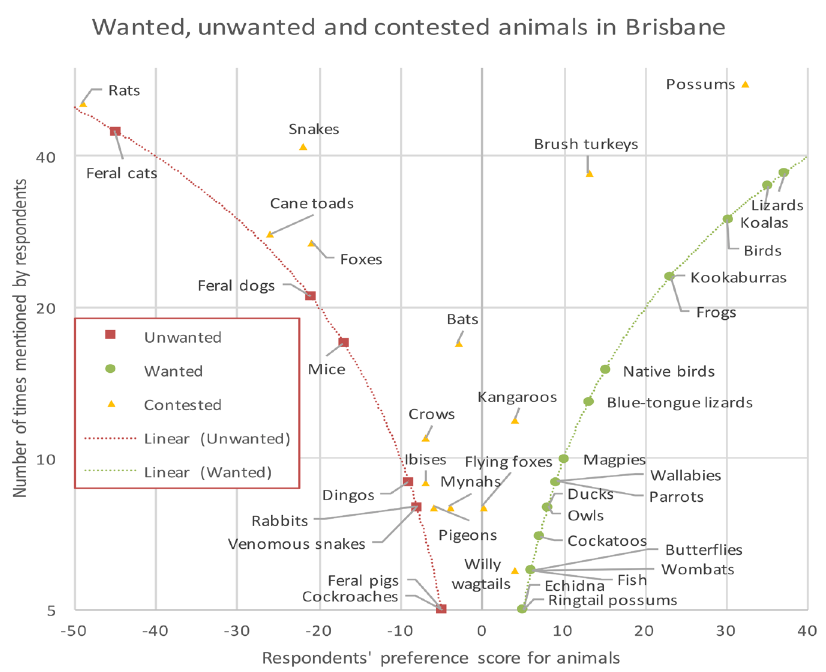
Fig. 1. Brisbane respondents’ preferences for animals in their neighbourhood.